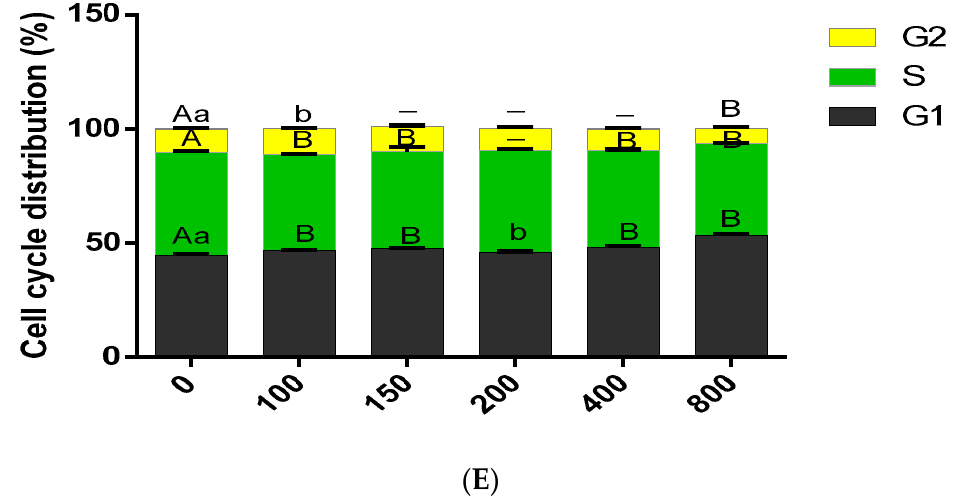
Figure 1. The effects of Chitosan oligosaccharide (COS) at different concentrations (0, 100, 150, 200, 400 and 800 μ g/mL) on the viability, proliferation and cycle distribution of bovine mammary epithelial cells (BMECs) were observed after they were treated for 24, 36 and 48 h respectively. ( A ) CCK8 reagent was used to detect the BMECs viability at 450 nm. The Y -axis showed the percentage of cell survival, and the X -axis showed the doses of COS. ( B ) The proliferation of BMECs after COS treatment was measured by the Edu cell proliferation detection kit, the scale bar stands 200 µ m. DAPI (blue), EdU (red). ( C ) the percentage of Edu positive cells in the total number of cells. ( D ) under COS culture at different concentrations, the BMECs cycle distribution was detected by flow cytometry. Y -axis represents the cell count analyzed, while X -axis indicates the DNA content of PI- stained cells. ( E ) The percentage of cells distributed in different stages of cell cycles (G1 phase, S phase and G2 phase) is represented by a histogram. Data were the mean ± SE from three independent experiments. Different small letters showed significant difference ( p < 0.05), different capital letters showed extremely significant difference ( p < 0.01), and the same letters or unmarked letters had no significant